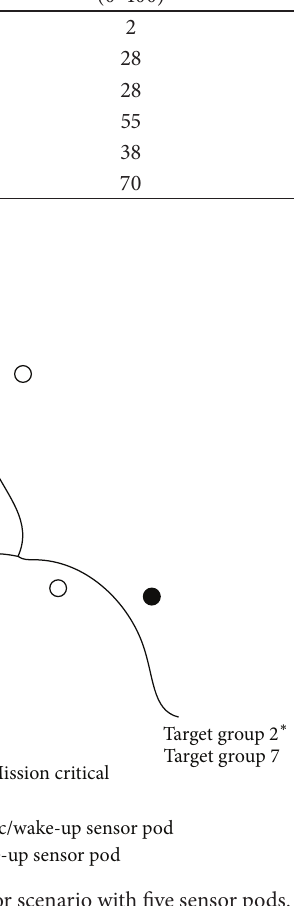
Figure 19: Multisensor scenario with five sensor